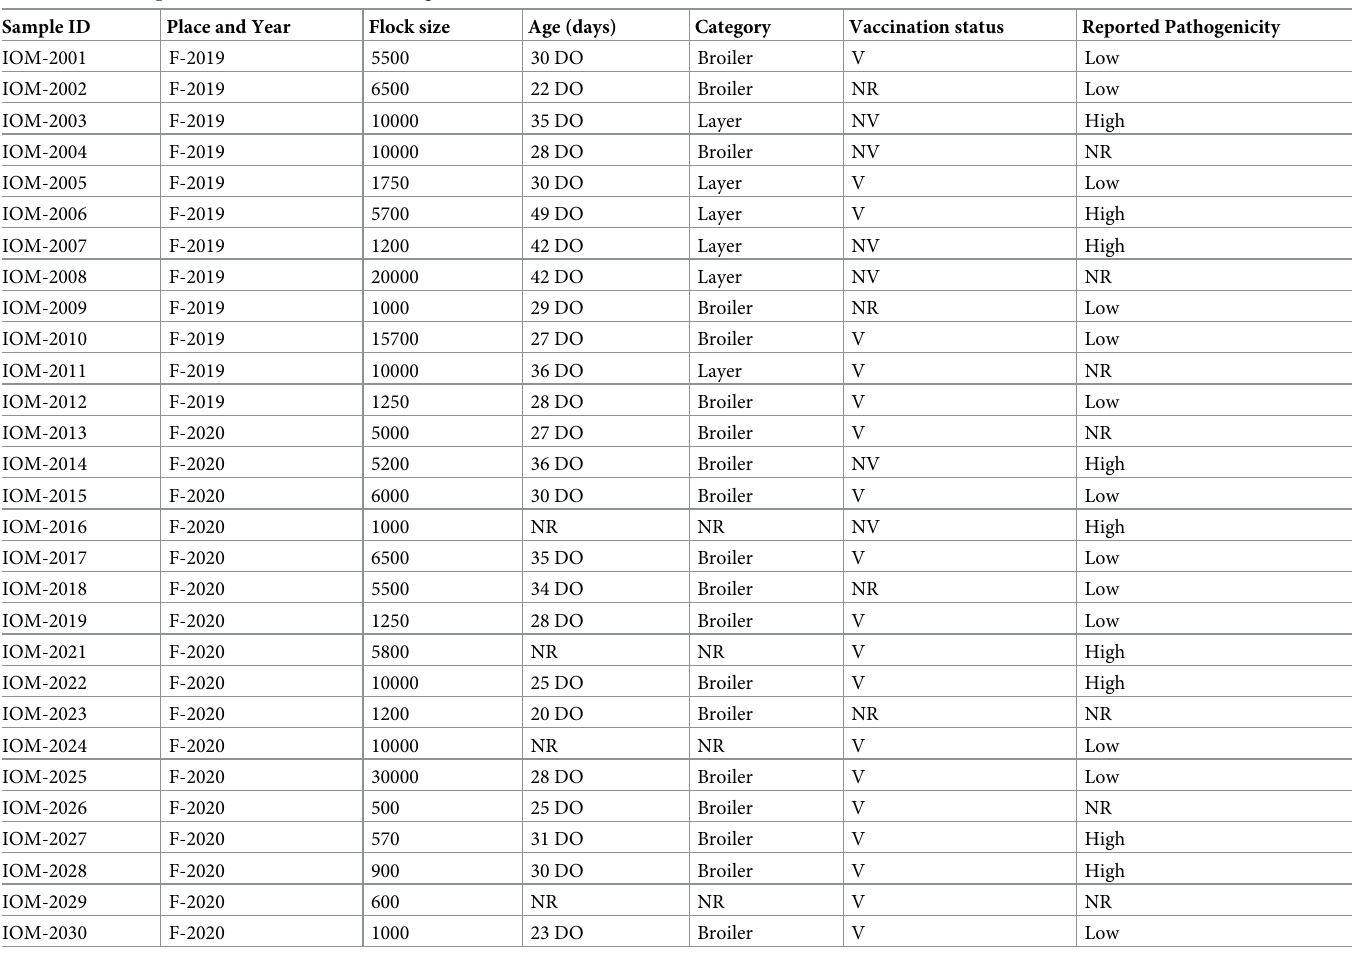
Table 1. Field samples collected from flocks with signs of